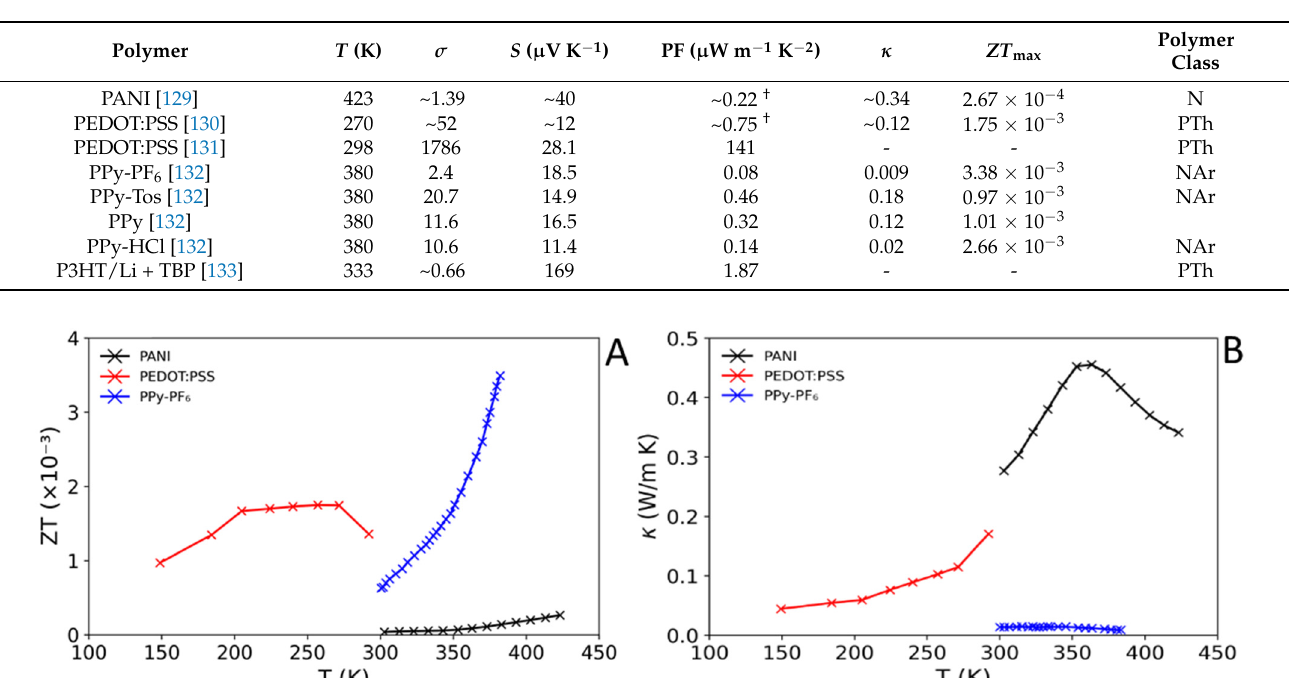
Table 5. Thermoelectric properties of more typical polymer TEs used within inorganic/polymer composites at the stated temperature ( T ). P 3 HT = Poly(3-Hexylthiophene). σ is electrical conductivity, S is the Seebeck coefficient, PF is the power factor and κ is the thermal conductivity. All values are reported at the maximum of the figure of merit, ZT max . † Calculated from literature values.